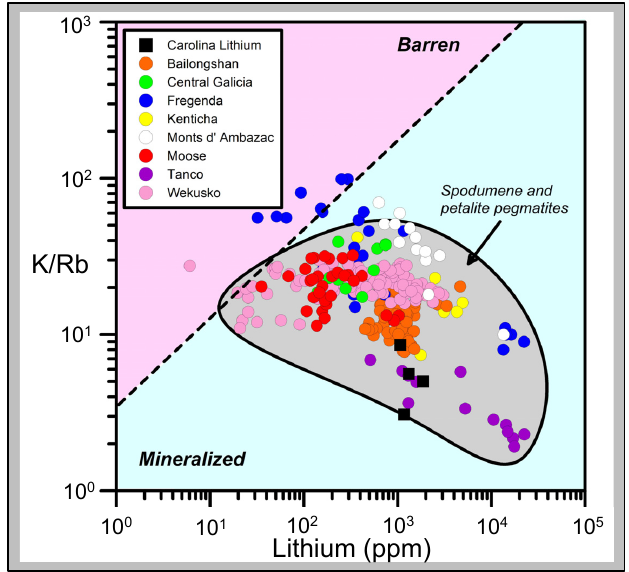
Figure 14. Comparison of muscovite K/Rb-Li (ppm) systematics for the CLP prospect with muscovite K/Rb-Li relationships for other Li-pegmatites worldwide: Bailongshan field, China [99]; Central Galicia field, Spain [100]; Fregenda area, Spain [101]; Kenticha pegmatite, Ethiopia [102]; Monts d’ Ambazac field, France [103]; Moose pegmatite, Northwest Territories, Canada [104]; Tanco pegmatite, Manitoba, Canada [105]; and Dike 1, Wekusko Lake field, Manitoba, Canada [106].